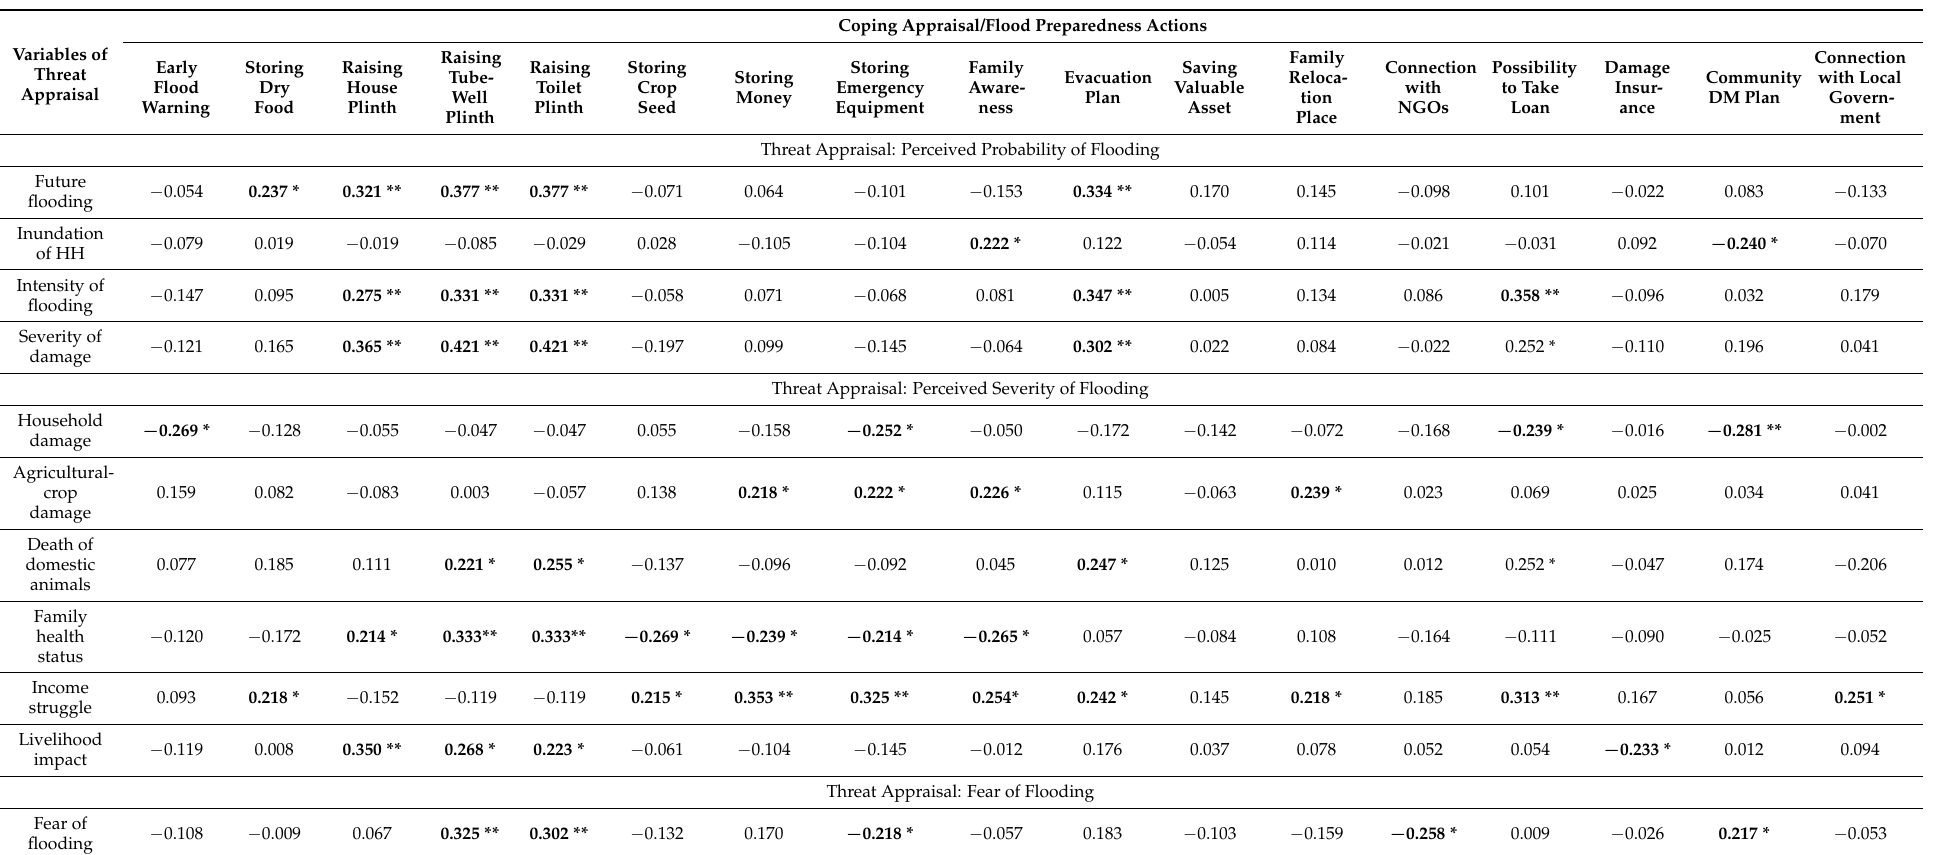
Table A1. Correlations among variables of threat appraisal and coping